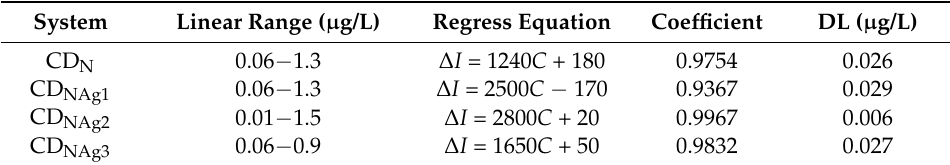
Table 4. Comparison of some reported molecular spectral methods for ACT.